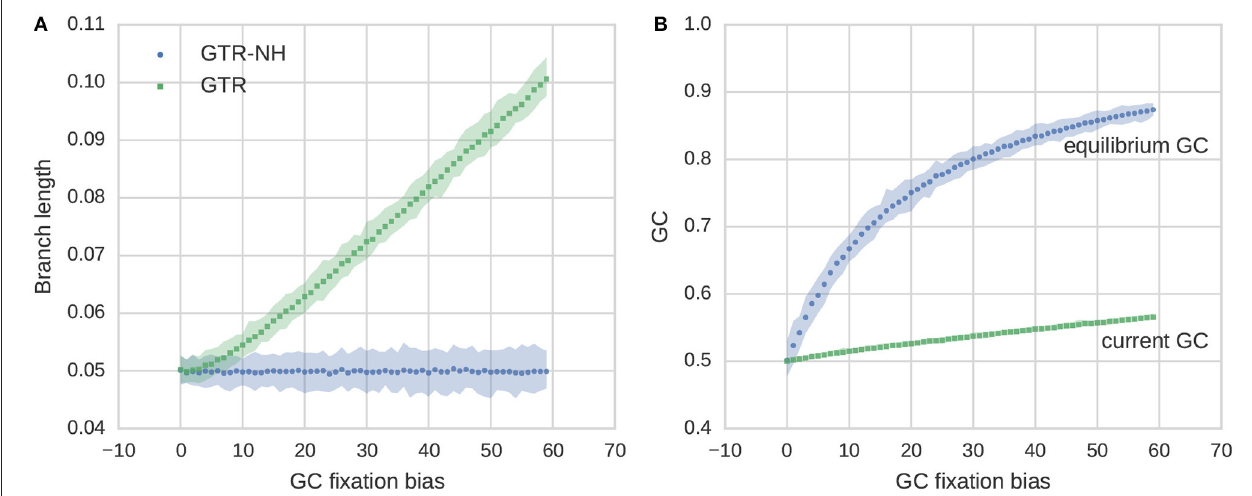
FIGURE 2 | Features of GC content evolution in a terminal branch simulated under GC fixation bias. The terminal branch length under consideration is set to 0.05. (A) Estimated branch lengths under varying strength of GC fixation bias for stationary (GTR) and non-stationary (GTR-NH) models and their 95% CIs. (B) GC content evolution, shown is equilibrium GC (GC*) estimated from the GTR-NH model and GC content at the tip of the branch (current GC). Because of the short branch length GC content is far from its equilibrium.